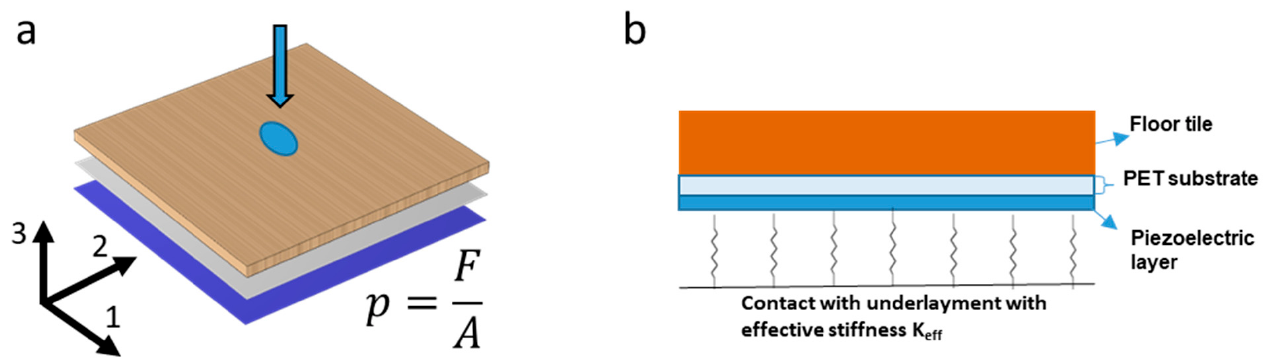
Figure 4. FEM model with ( a ) 3D scheme and ( b ) description of the individual domains. The contact pressure is applied as a boundary condition on top. The sensor pixel array is represented by a set of electrode areas on the top boundary of a continuous piezoelectric layer. This simplifies the study of the optimal distribution of the pixels as well as the possible crosstalk between them. The underlayment is modeled as a spring support with an effective stiffness K eff .